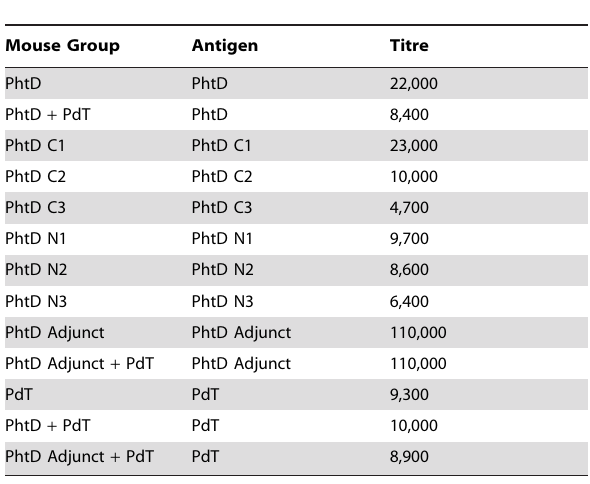
Table 4. Antibody titres of pooled sera from immunised mice before challenge with